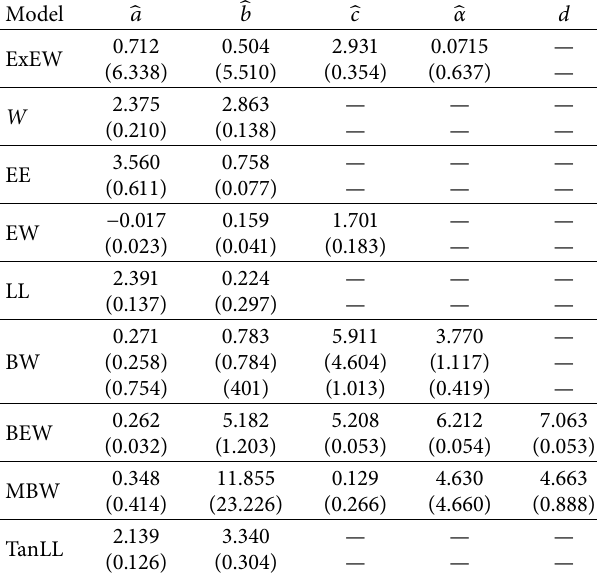
Table 7: The MLEs of the competing models with standard errors for windshield data.